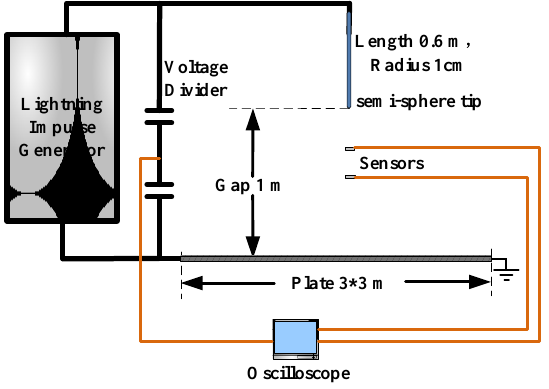
Figure 24. Configuration of a rod-plane air gap discharge experiment [85] (Copyright © 2011 AIP, Reprinted with permission).